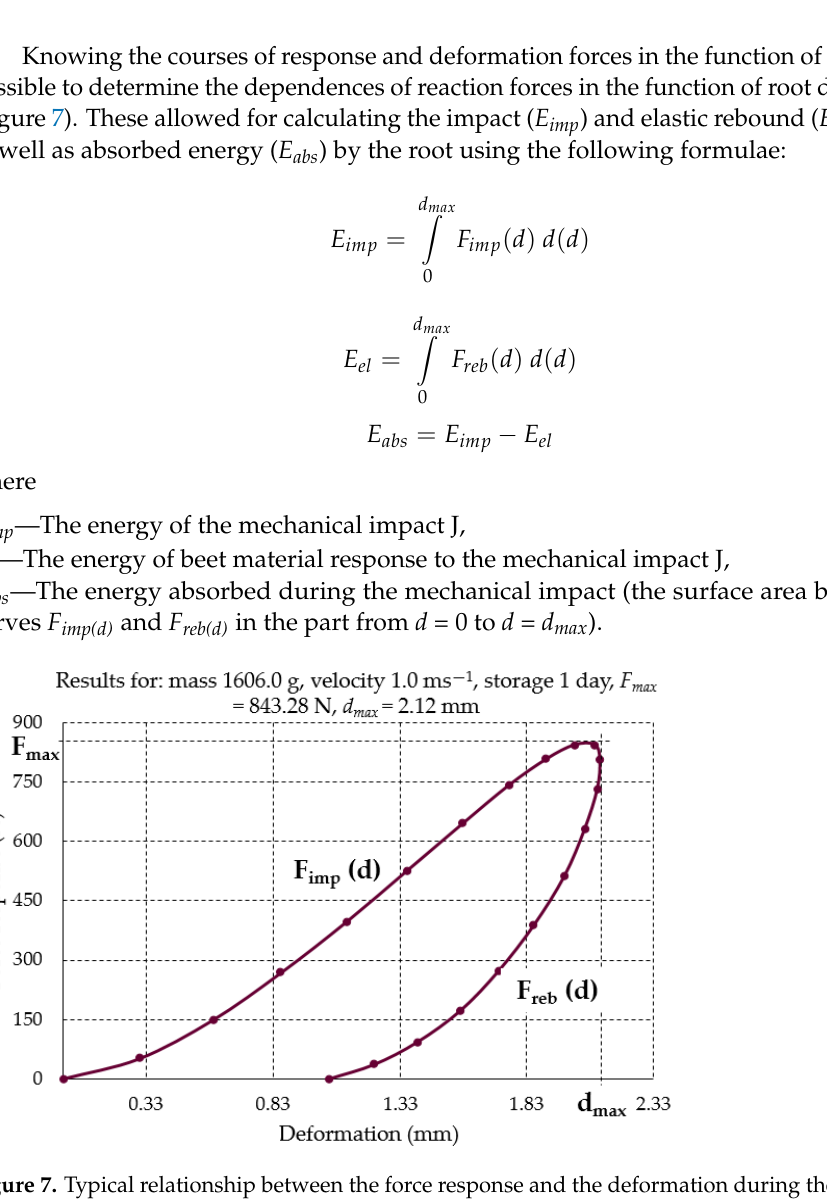
Storage time, S (day) t